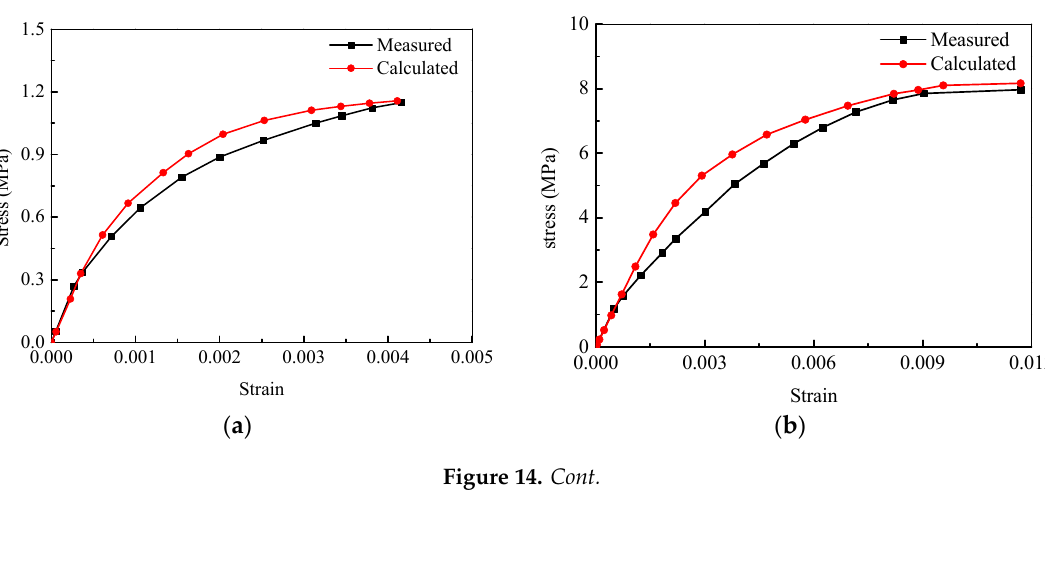
Measured Calculated